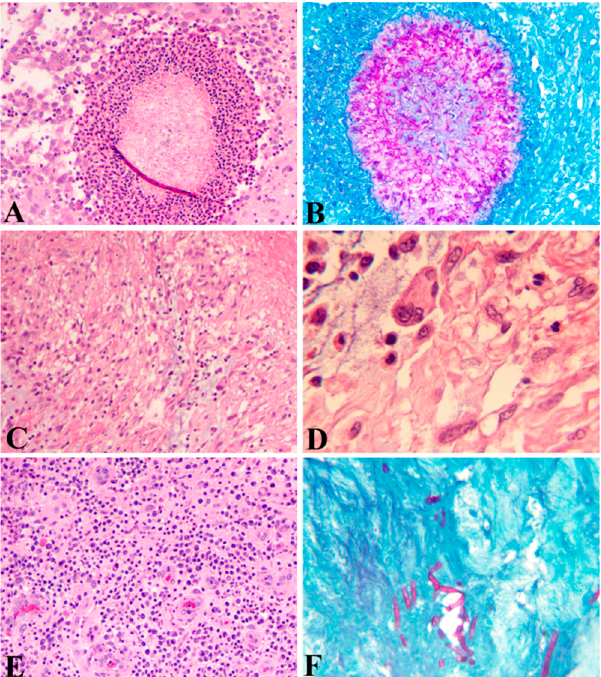
Figure 1. Histopathology of eumycetoma. ( A ) Fungal elements surrounded by a layer of neutrophils and then surrounded by plasma cells, macrophages, lymphocytes, eosinophils, and blood vessels (HE; A; 100 × 1). ( B ) Periodic Acid Schiff (PAS) stain showing fungal elements (100 × 1). ( C ) (HE; 100 × 1) and ( D ) (HE; 400 × 1) Macrophages and Langerhans giant cells predominant in a granuloma. ( E ) Epithelioid granulomas containing lymphocytes, plasma cells, and epithelioid cells, and proliferated blood vessels (HE; 100 × 1). ( F ) PAS stain showing a small number of fungal elements in a granuloma (PAS; 100 × 1).